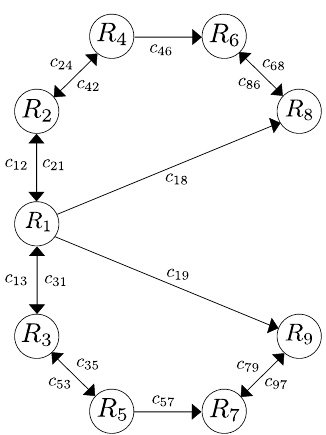
Figure 4. Fourth desired formation.